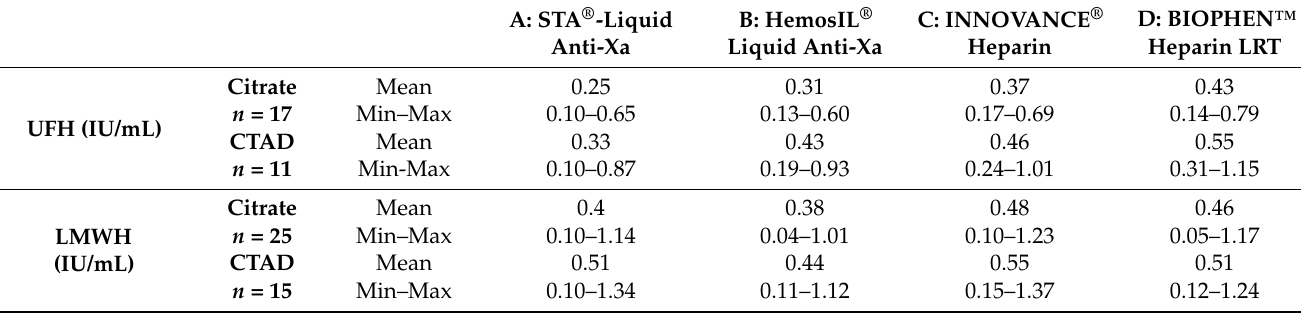
Table 4. Mean heparin concentrations, in IU/mL, measured with the 4 different anti-FXa reagents on the four subgroups: UFH-citrate, LMWH-citrate, UFH-CTAD, and LMWH-CTAD); combinations A and B were used to measure lower concen- trations than combinations C and D, although the causes differed (absence of DS in A and combination of UFH and LWWH for calibrators in